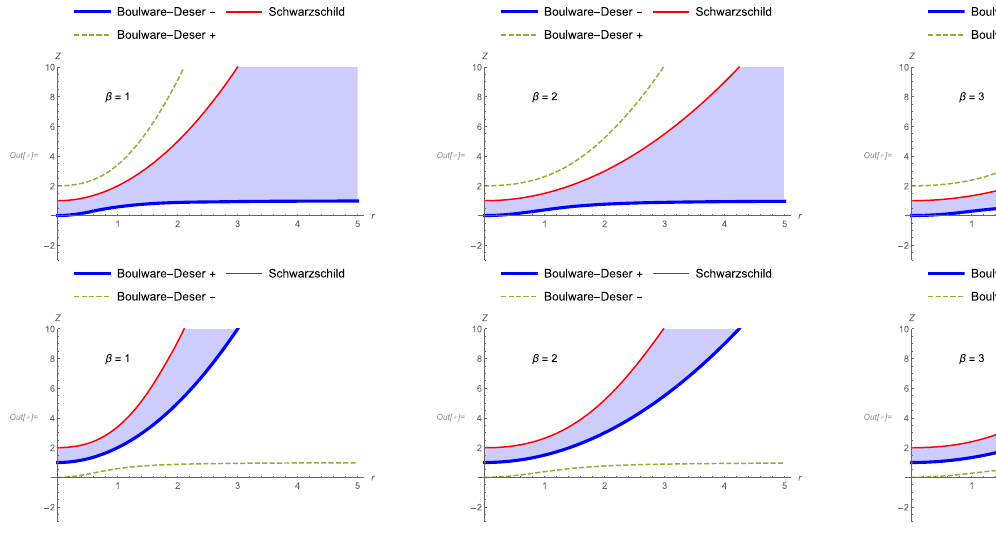
Fig. 1 Plots of feasible spatial potential regions for C 1 = 0